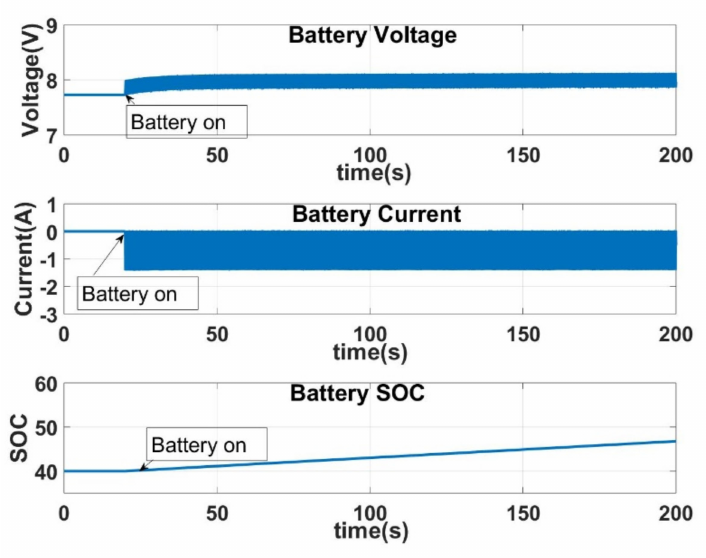
Figure 9. Simulated battery parameters during